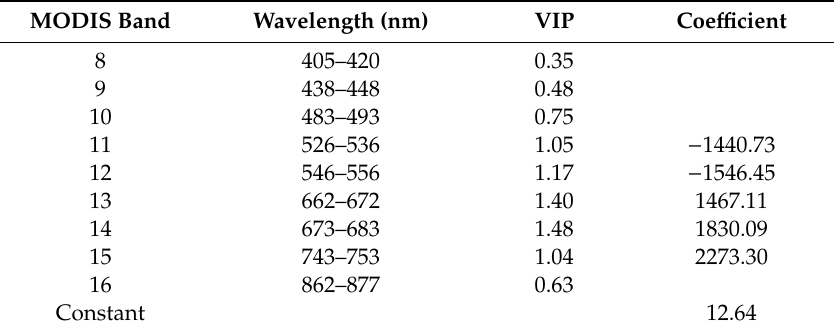
Table 1. Simulated MODIS PLSR Model